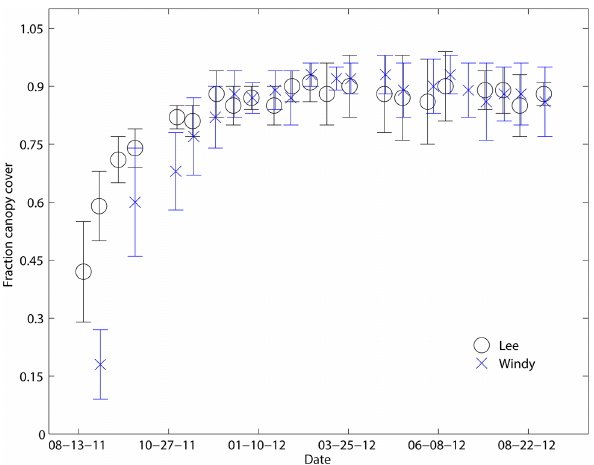
Figure 2. Measured mean and standard deviation of fractional veg- etation cover from TetraCam for Windy and Lee